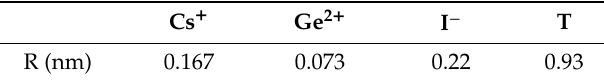
Table 4. The ionic radium of CsGeI 3 .